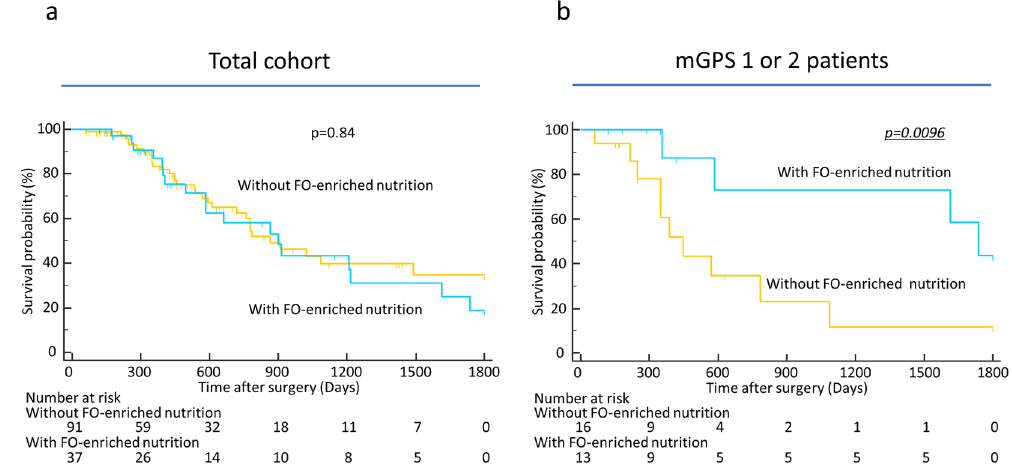
Figure 2. Prognostic impact of FO-enriched nutritional intervention in GI cancer patients. ( a ) Kaplan–Meier survival curves showing the OS of GI cancer patients in association with the nutritional intervention in the total cohort (n = 128). The OS rate of the GI cancer patients receiving the nutritional intervention (n = 37) did not significantly change compared with those not receiving FO-enriched nutrition (n = 91) (P = 0.84; log- rank test). ( b ) OS analysis of GI cancer patients with an mGPS of 1 or 2 based on treatment with FO-enriched nutrition. The patients with an mGPS of 1 or 2 who received FO-enriched nutrition had a better prognosis than the patients with an mGPS of 1 or 2 who did not receive FO-enriched nutrition (p = 0.0096; log-rank test). All statistical tests were two-sided.